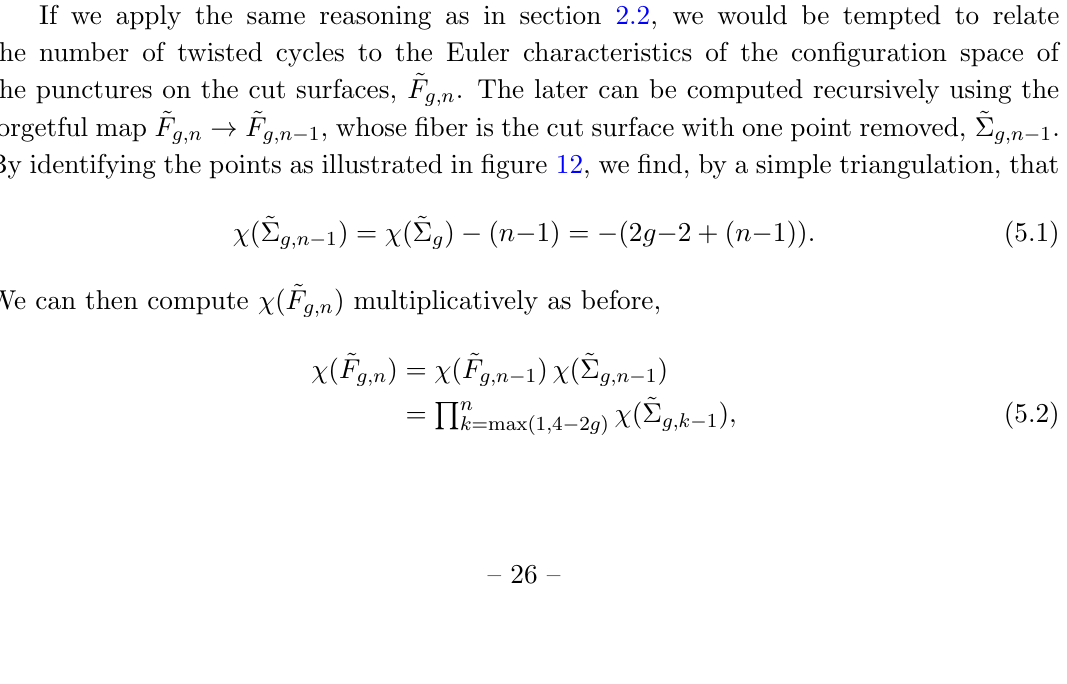
or A 00 must i i